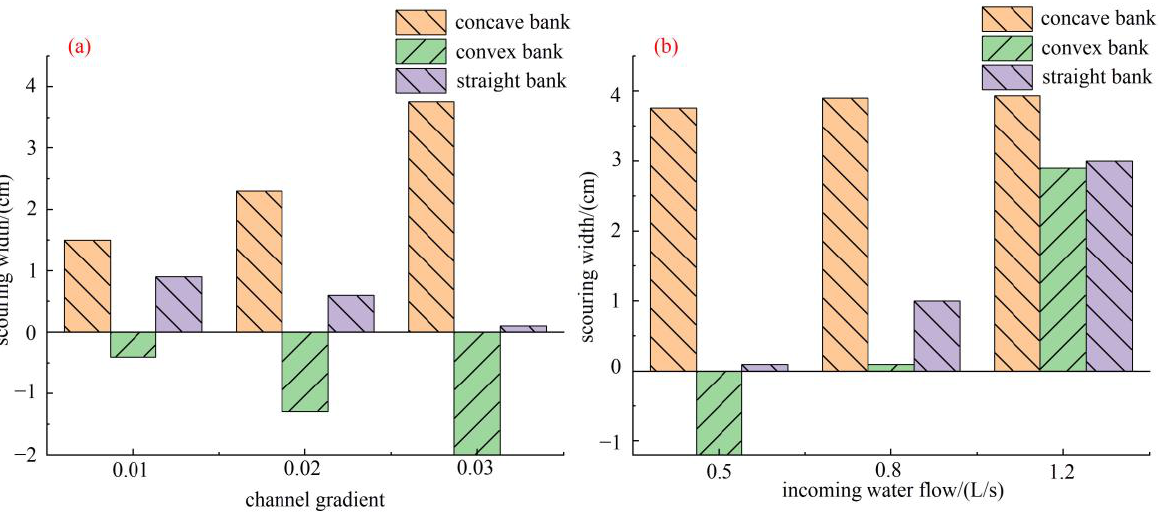
Figure 7. ( a ) The scour width varies when the channel ratio is a variable. ( b ) The scour width varies when incoming water flow is a variable.